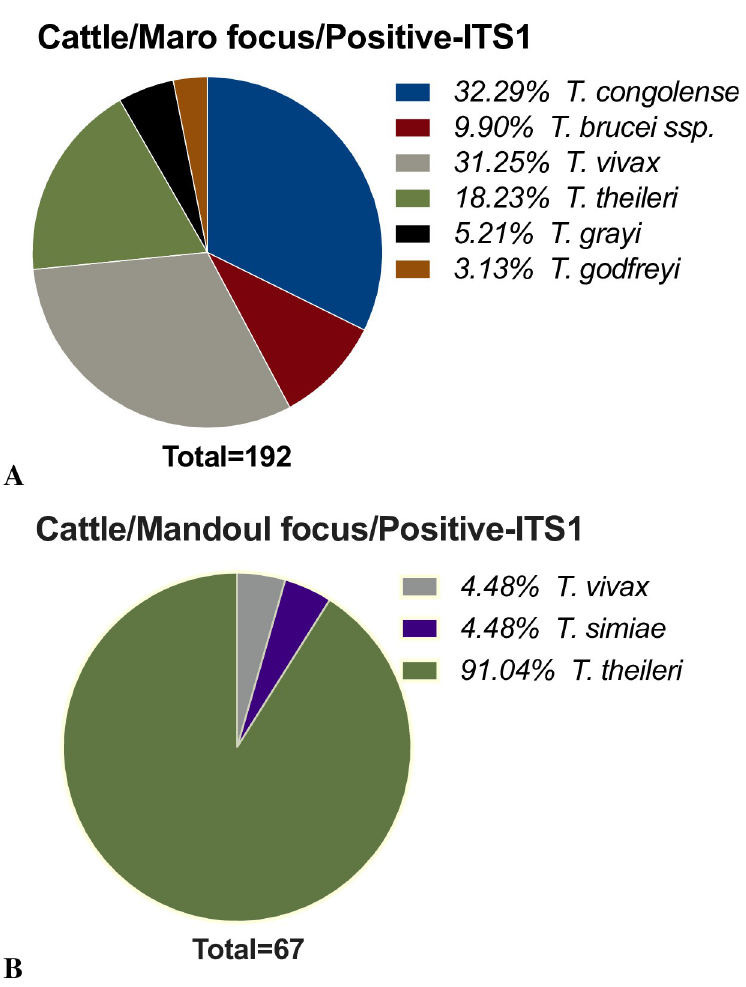
Fig 3. Overall trypanosomes frequency in cattle. A- Maro HAT/AAT focus; B- Mandoul HAT/AAT